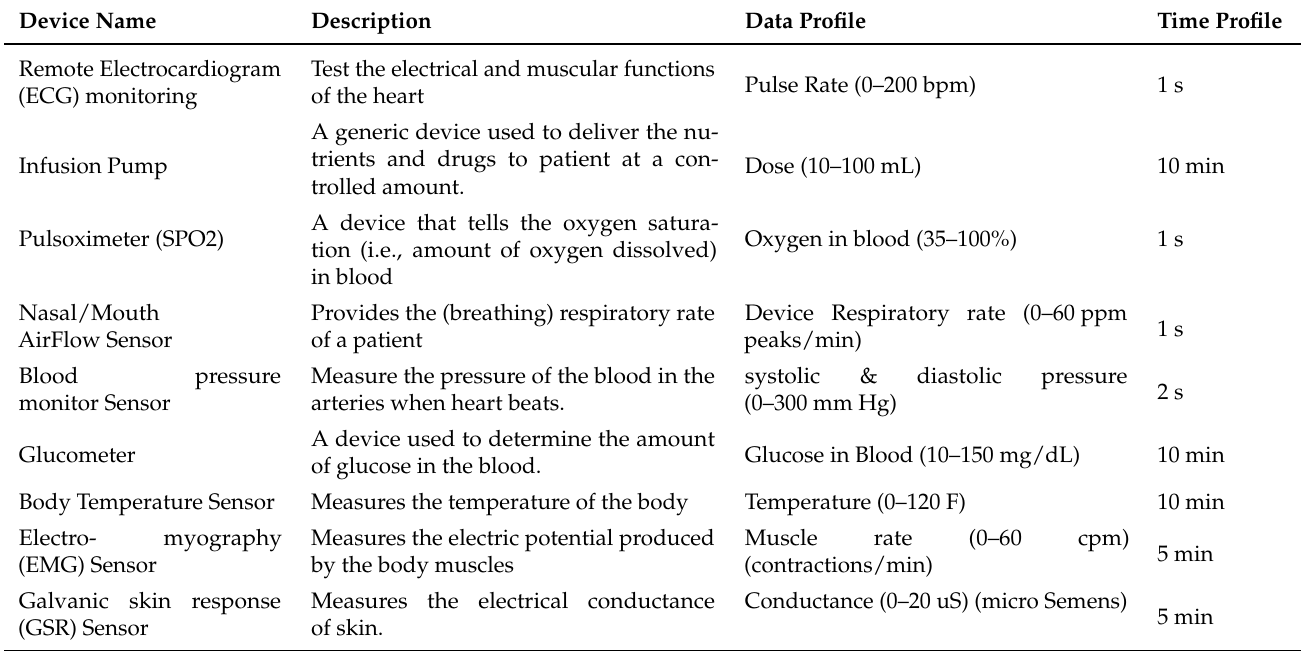
Table 2. Patient monitoring